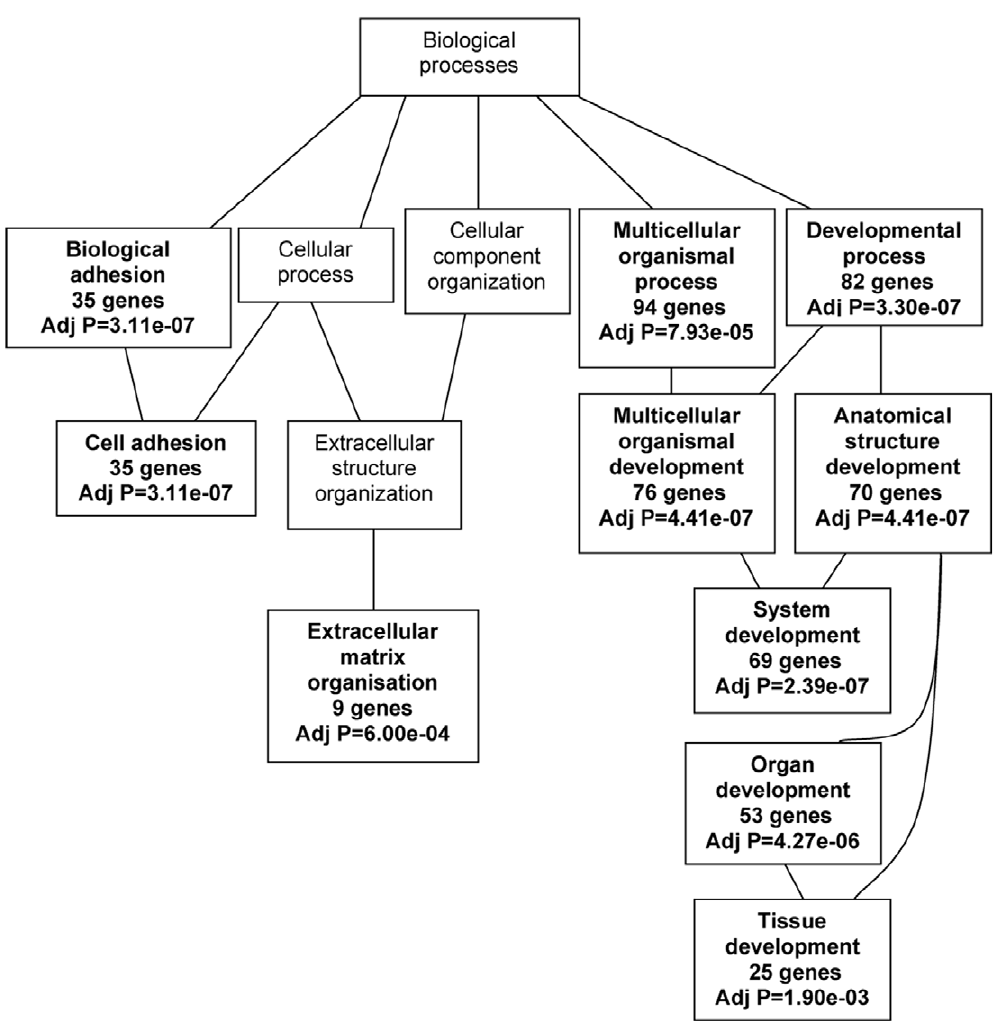
Figure 2. Significant biological processes associated with the differentially expressed genes as identified by Genomatix. The differentially expressed genes in all models of DCIS in comparison to MCF10A were analyzed by WebGestalt2 tool. A Fisher’s exact test was used to determine statistical significance with a significance level of 0.05. The p -values and the number of genes associated with a particular function or process are indicated in bold in the respective